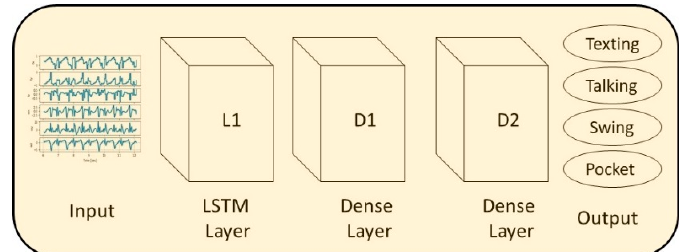
Figure 4. The LSTM network architecture used for evaluation of SLR.